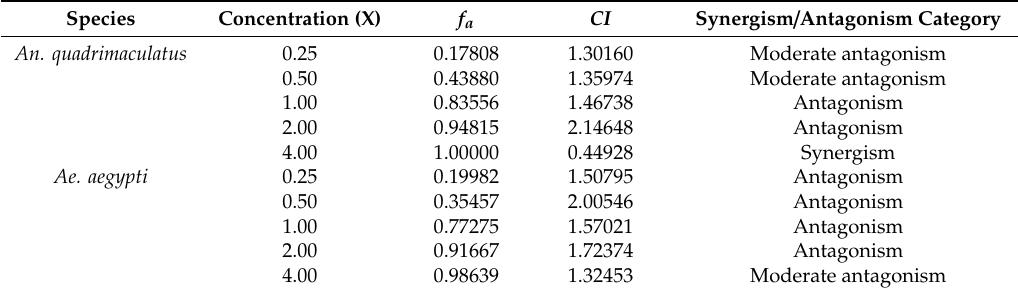
Table 3. Lethality fraction ( f a ) a ff ected by the combined larvicide of DL-methionine and Bacillus thuringiensis subspecies israelensis (BTI) concentration as a proportion and the calculated combination indices ( CI ) for Anopheles quadrimaculatus (n = 4) and Aedes aegypti (n = 6) and at each actual concentration tested in a 48-h exposure in glass jars. CI calculated using the software Compusyn and synergism / antagonism categories provided according to Chou and Martin [30].